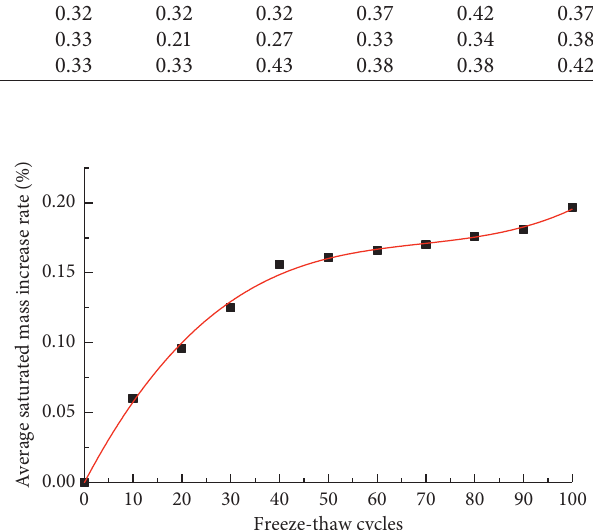
Figure 5: Change rate of average saturated water quality after different freeze-thaw